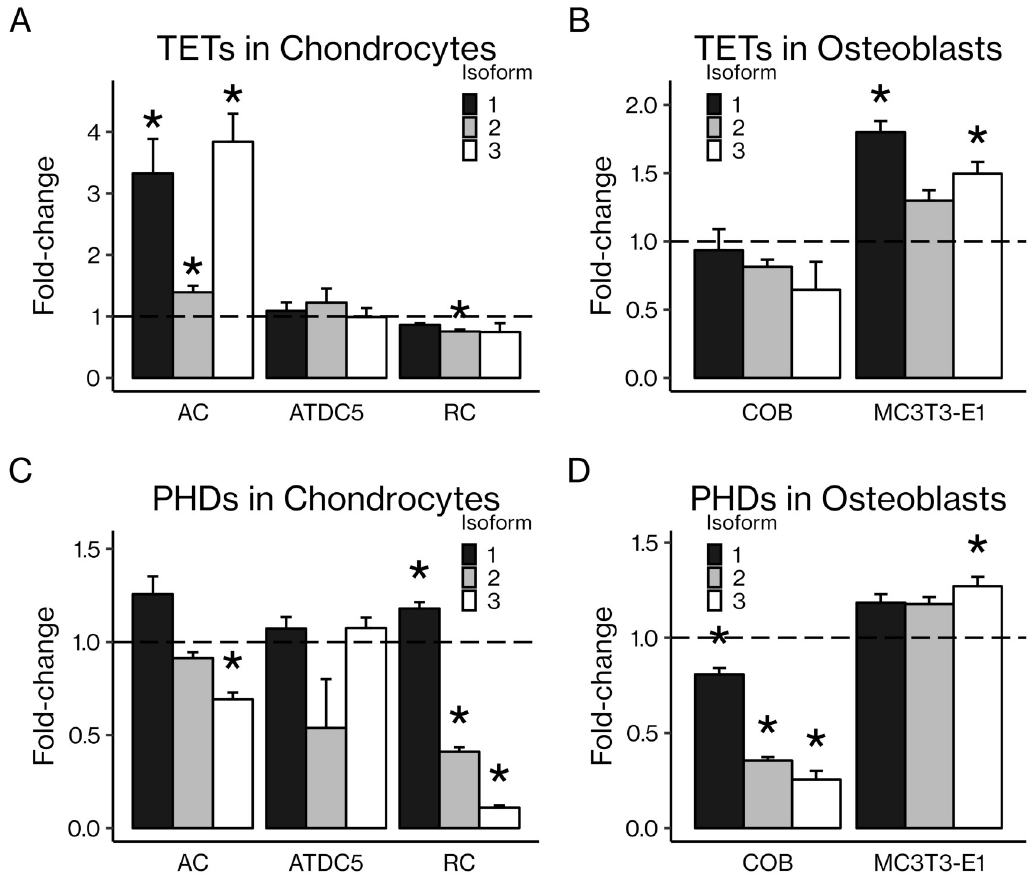
Fig 5. All TETs and PHDs are expressed in chondrocytes and osteoblasts at the mRNA level, and expression of many TETs and PHDs is regulated by AA. Primary articular chondrocytes (AC), ATDC5 chondrocytes, primary rib chondrocytes (RC), primary calvarial osteoblasts (COB), and MC3T3-E1 pre-osteoblasts were cultured in vitro and treated with AA (50 μ g/mL) before RNA extraction and RT-qPCR. Expression of TETs in (A) chondrocytes and (B) osteoblasts as well as PHDs in (C) chondrocytes and (D) osteoblasts are reported. Results are presented as mean fold-change ± SEM. � P < 0.05 vs. control (Student’s t -test), n = 3–4 per